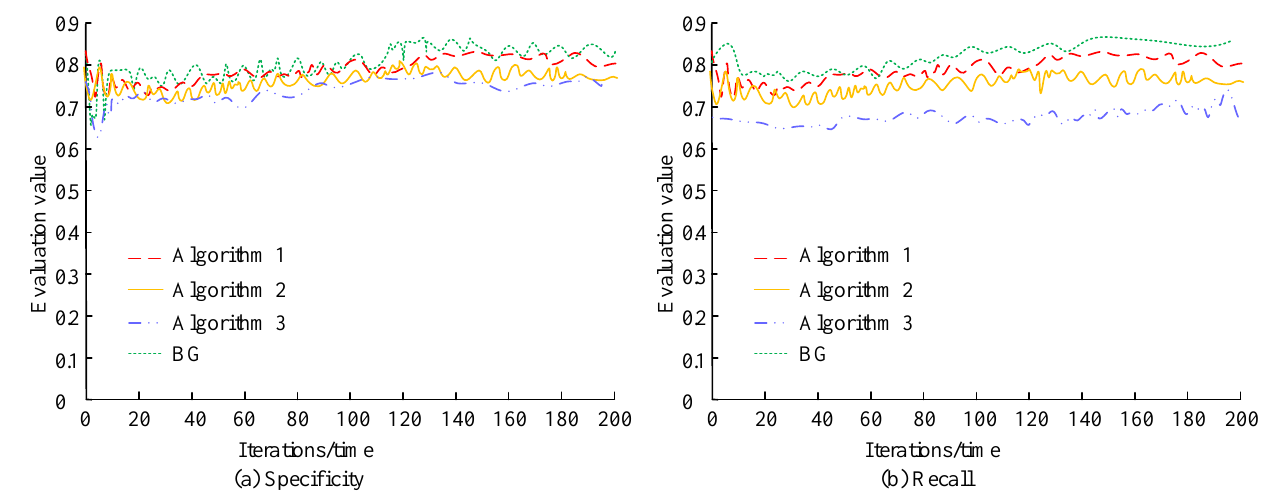
Figure 8. Recall rate and specificity of four minimum cost maximum flows under different iterations. (It can be seen from the figure that with the increase of iteration times, the recall rate and specificity of the four minimum cost maximum flows gradually become stable. Among them, compared with the other three minimum cost maximum flow algorithms. ( a ): BG iterative algo- rithm has the highest specificity. The stable recall rate of the other three minimum cost and maxi- mum traffic algorithms is between 65.58% and 78.96%. ( b ): The specificity of the BG iteration algo- rithm is the highest, and the stability specificity of the other three algorithms is between 66.83% and 78.35%). Table 1. Minimum cost and maximum flow of energy model for ordinary residential buildings in